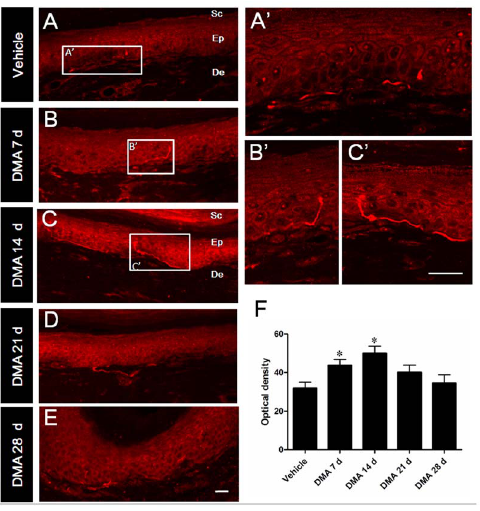
Figure 5. Immunofluorescent staining of TRPV1 in plantar skin of hind paw with the progression of DMA. A–E, typical photograsph of TRPV1 immunoreactivities in vehicle and DMA model rats at varied time points. A 9 –C 9 , the magnified pictures from the rectangle areas in A–C. F, optical density analysis of TRPV1 immuno- reactivities in epidermis and dermis displaying strong enhancement on DMA 7 d and 14 d. Sc, Ep and De are the abbreviation of stratum corneum, epidermis and dermis, respectively. Scale bar =20 m